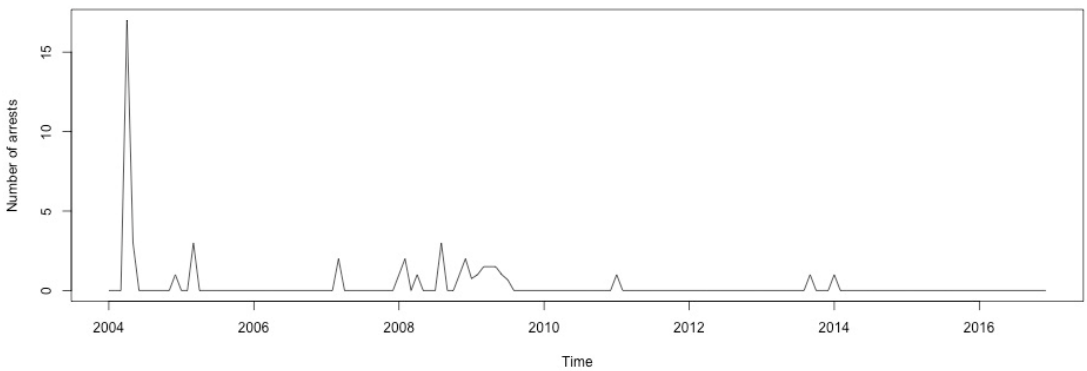
Figure A49. Heroin organized crime Vietnamese nationals arrests 2004–2016 in the Czech Republic and structural breaks.